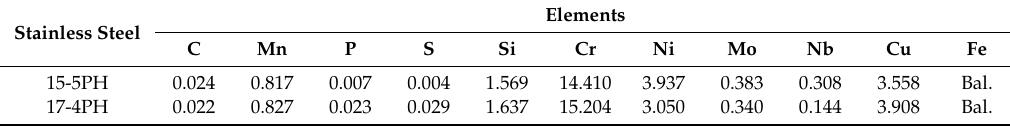
Table 1. Chemical composition of the used stainless steels (wt.